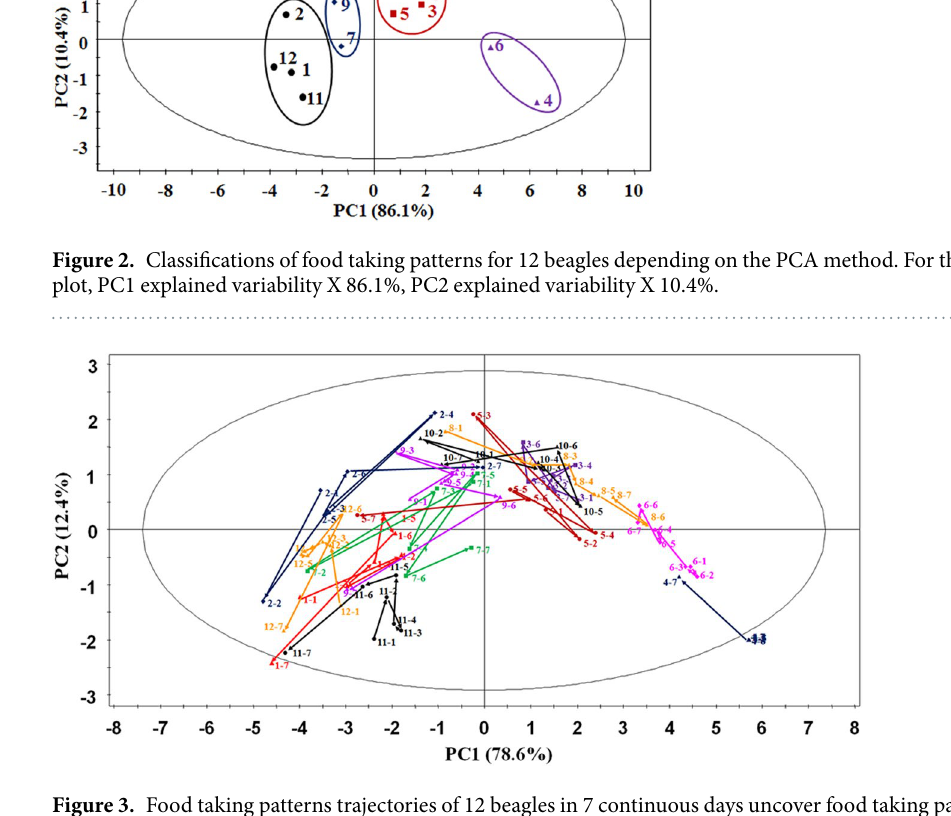
Figure 3. Food taking patterns trajectories of 12 beagles in 7 continuous days uncover food taking patterns variation to each beagle. For the score plot, PC1 explained variability X 78.6%, PC2 explained variability X 12.4%; “i,j” represented the food intake of No. i beagle on the j th